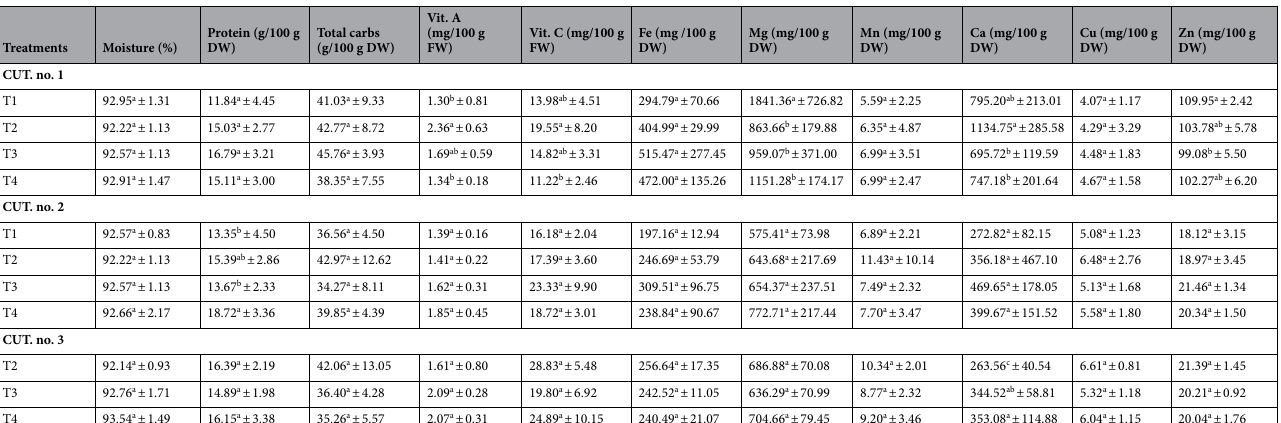
Table 5. Nutritive composition of Swiss chard for the three cuts. Nutritive composition values are expressed as mean ± SD (n = 6). Values within the same column in the same cut number having different superscript letters are significantly different at P < 0.05 (Tukey test). Treatments are; T1 Deep water culture, T2 6th October, T3 Benu Suef and T4 Fayoum. Carbs carbohydrates, Vit. A Vitamin A, Vit. C Vitamin C, Fe Iron, Mg Magnesium, Mn Manganese, Ca Calcium, Cu Copper, Zn